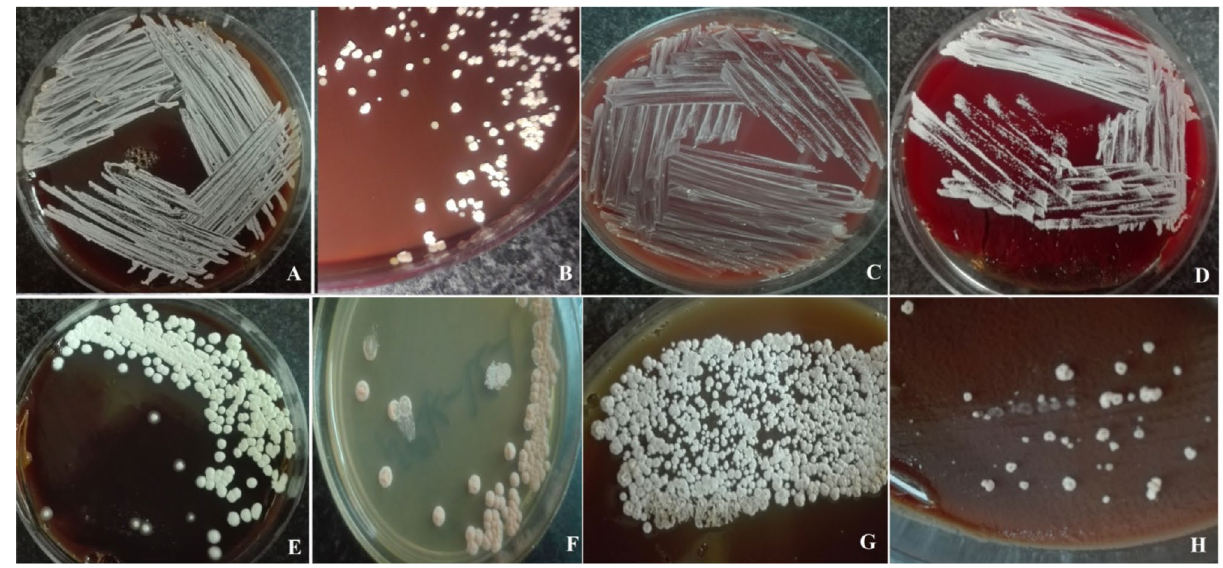
Figure 2. Pure colonies of isolated species ( A ) Nocardia cyriacigeorgica, ( B ) Nocardia kruczakiae , ( C ) Nocardia flavorosea, ( D ) Nocardia asteroides , ( E ) Streptomyces griseus , ( F ) Nocardia cerradoensis , ( G ) Nocardia caishijiensis , ( H ) Prauserella muralis.